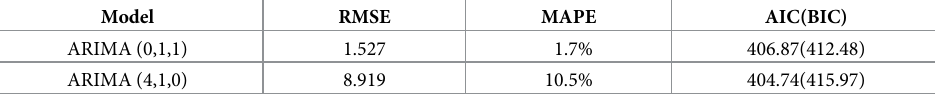
Table 5. Characteristics of the best Arima fitting model for PM2.5 concentration in the training